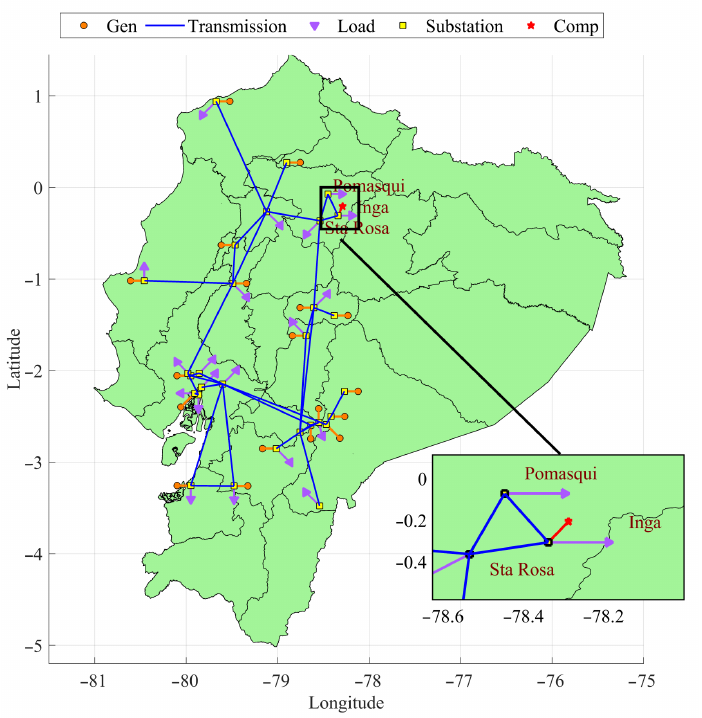
Figure 8. Location of compensation in the Ecuador